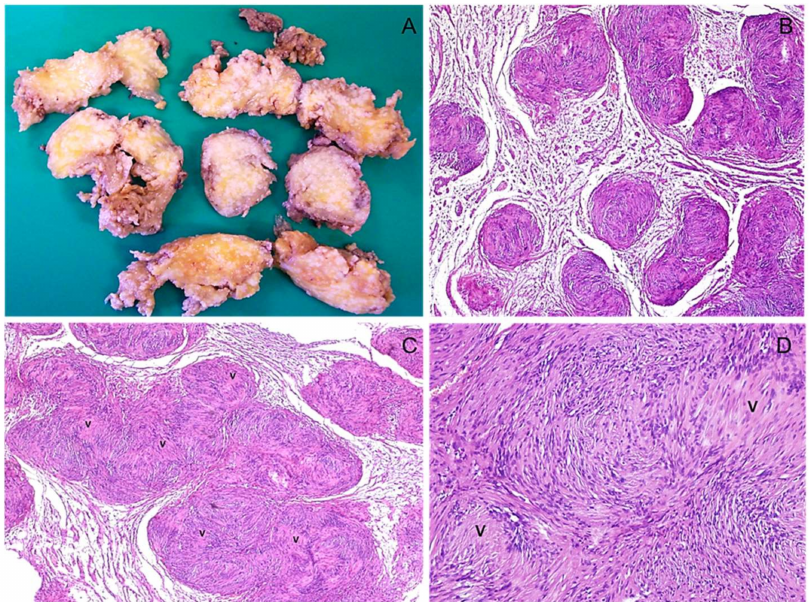
Figure 16. Plexiform schwannoma in a patient with NF2-related schwannomatosis. ( A ) Gross appear- ance of an abdominal plexiform schwannoma showing a multinodular mass with a plexiform pattern and greyish color. ( B ) At low magnification, the plexiform growth pattern can be appreciated. Verocay bodies can be observed at both low ( C ) and higher ( D )